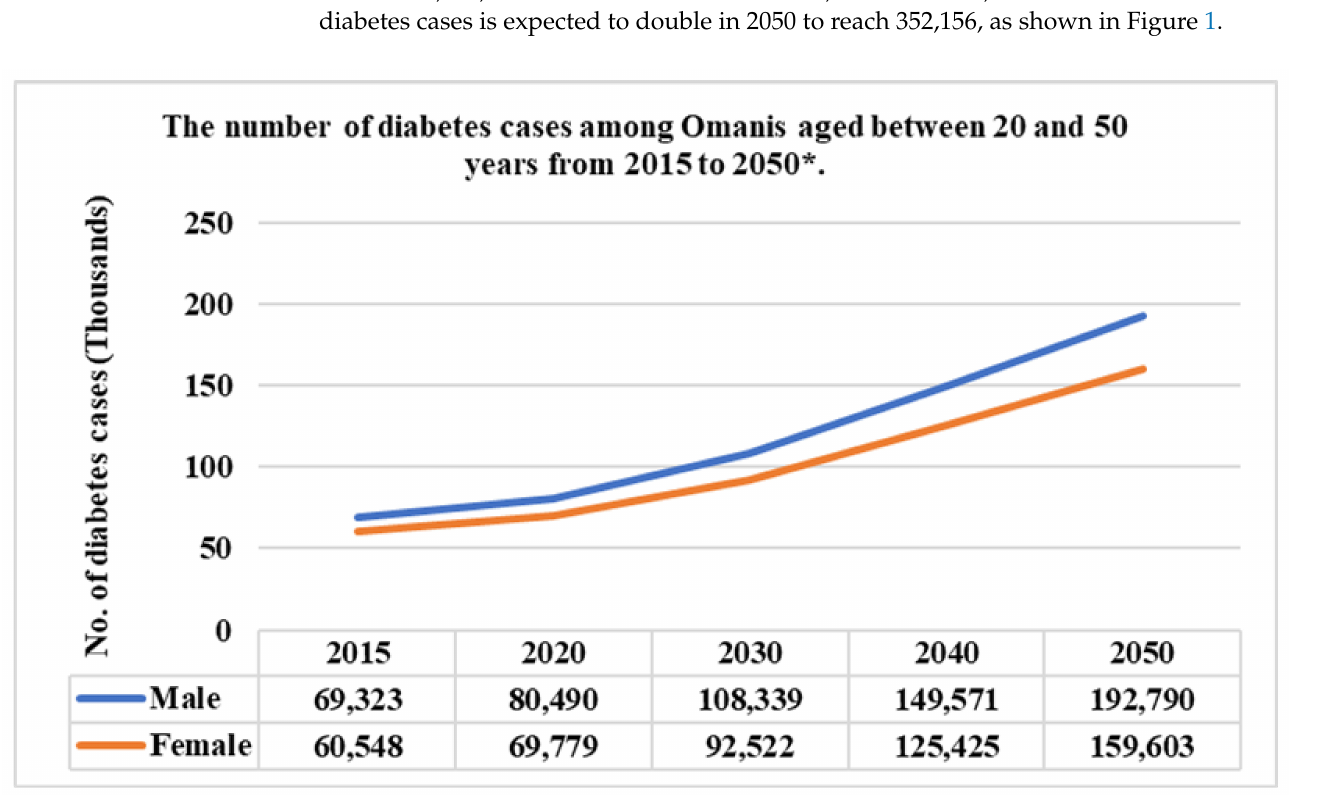
Figure 1. Diabetic Patients in Oman [8], * is the predicted